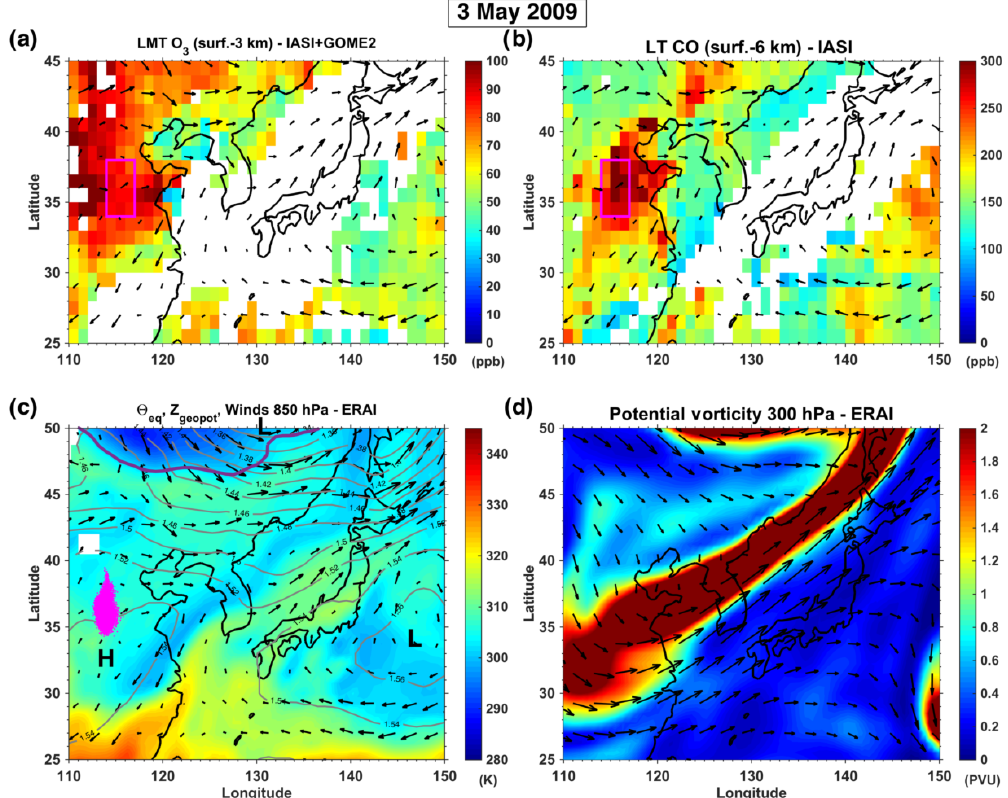
Figure 5. Distribution of gaseous pollutants and the meteorological situation over East Asia on 3 May 2009: (a) lowermost tropospheric ozone derived below 3km a.s.l. from IASI + GOME2; (b) carbon monoxide in the lower troposphere (below 6km altitude) retrieved from IASI measurements; (c) equivalent potential temperature θ eq (colour shading in K), geopotential height Z geopot (grey isolines every 20m) and winds at 850hPa from ERA-I reanalyses; (d) Potential vorticity (colour shading in potential vorticity units, PVU) and winds at 300hPa from ERA-I. The magenta rectangle in panels (a) and (b) indicates the overall location on 3 May 2009 of the tracked air masses during the ozone pollution outbreak of early May 2009, and the magenta dots in (c) correspond to the precise air parcels locations provided by HYSPLIT. The location of a cold front is shown by a violet curve in panel (c)